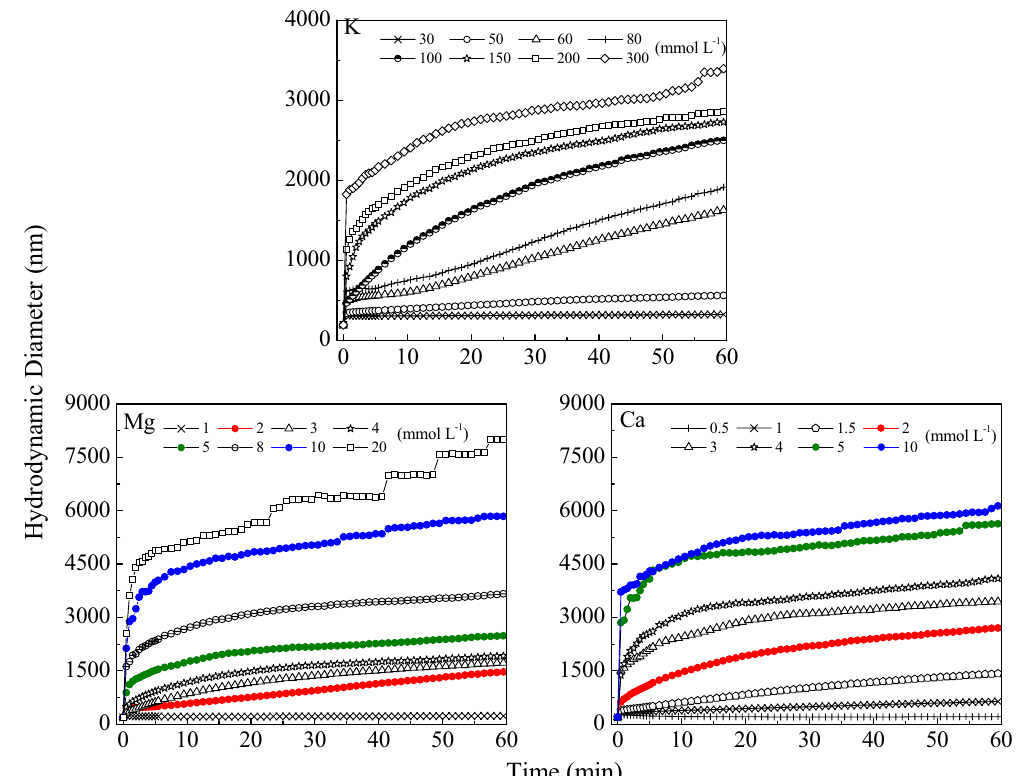
Figure 2. The average effective hydrodynamic diameters of the BSC particle aggregates changing with the experimental